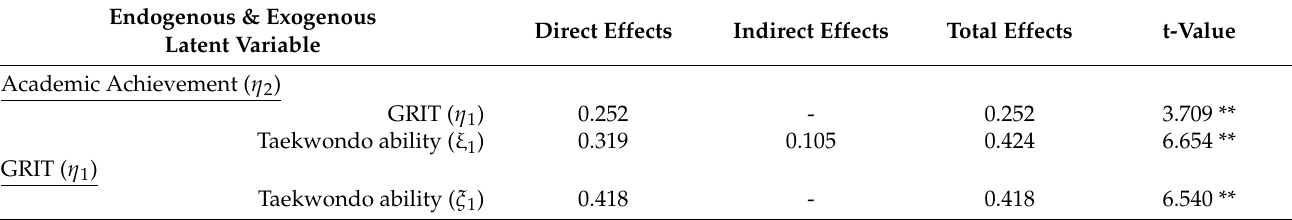
Table 5. Total and indirect effects of the research